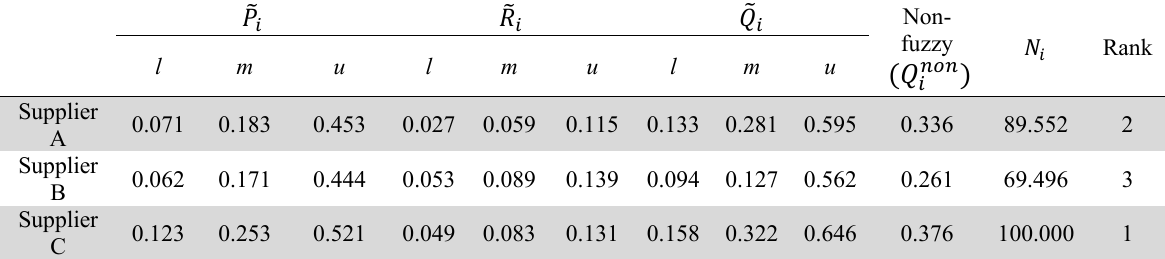
Final results and ranking with Fuzzy